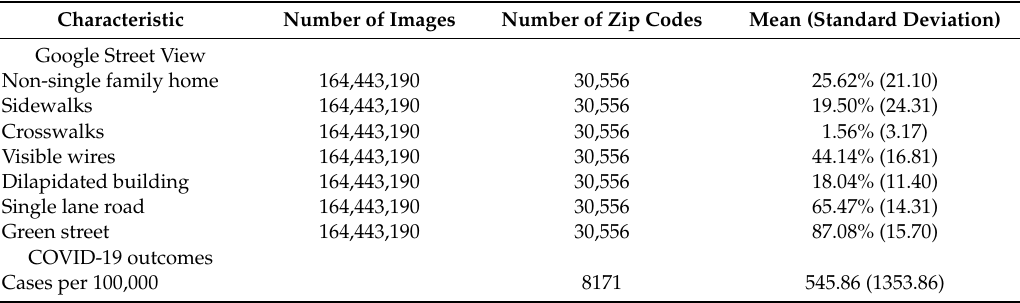
Table 1. Descriptive statistics, zip code